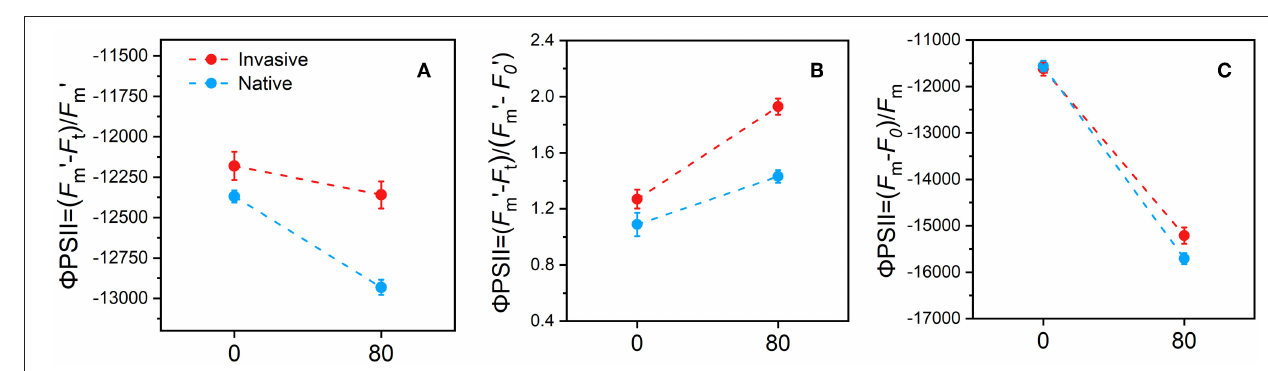
FIGURE 8 | Changes in chlorophyll fluorescence parameters in young-mature (i.e., just after reaching their final size) leaves of invasive and native plants during stress and long-term acclimation in response to cadmium (Cd) treatments (A) 8 PSII quantum yield of photosystem II (B) 8 PSII qP proportion of open photosystem II (C) 8 PSII F v /F m maximum quantum yield of photosystem II. Values are means ± standard error (SE).